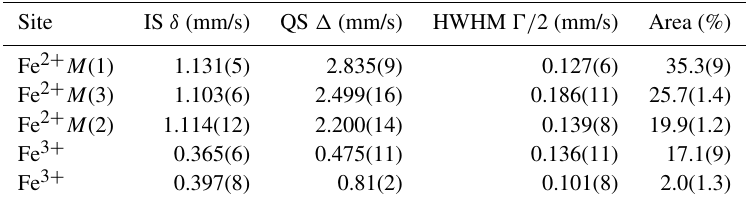
Table 1. 57 Fe Mössbauer parameters for glaucophane. IS indicates isomer shift; QS indicates quadrupole splitting; HWHM indicates half width at half maximum. The standard deviations ( σ n − 1 ) are in parentheses.